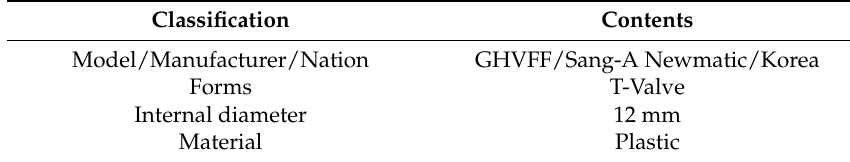
Figure 6. Picture of the hand valve. Table 4. Specifications of the hand valve.